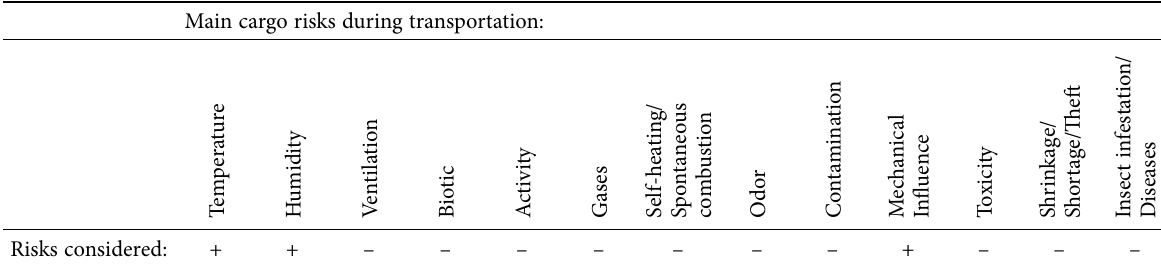
Table 2. Basic risk factors during transportation (additional privacy information) Main cargo risks during